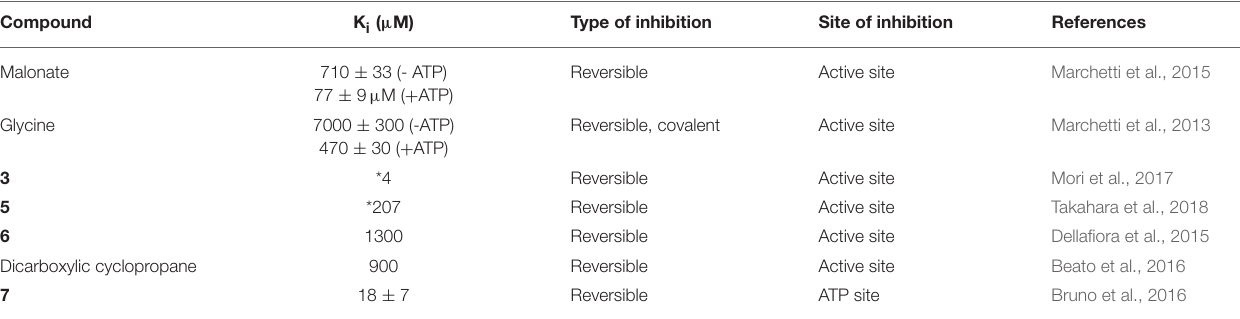
TABLE 3 | Selected inhibitors of